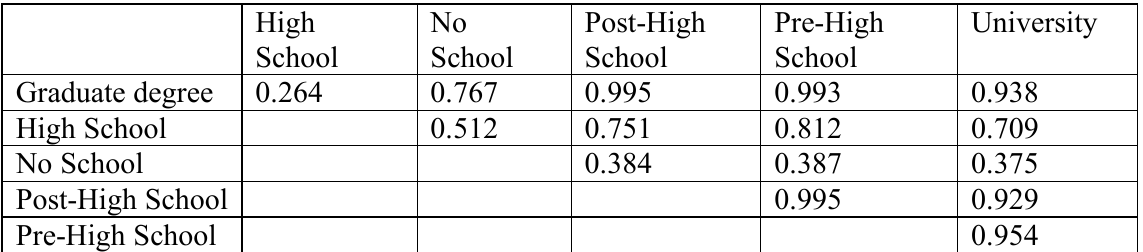
Table A3.3. GLMM model results for pairwise comparisons examining differences in crop plant richness based on education level of gardeners. Numbers show p-values for pairwise comparisons of different levels for reach factor.